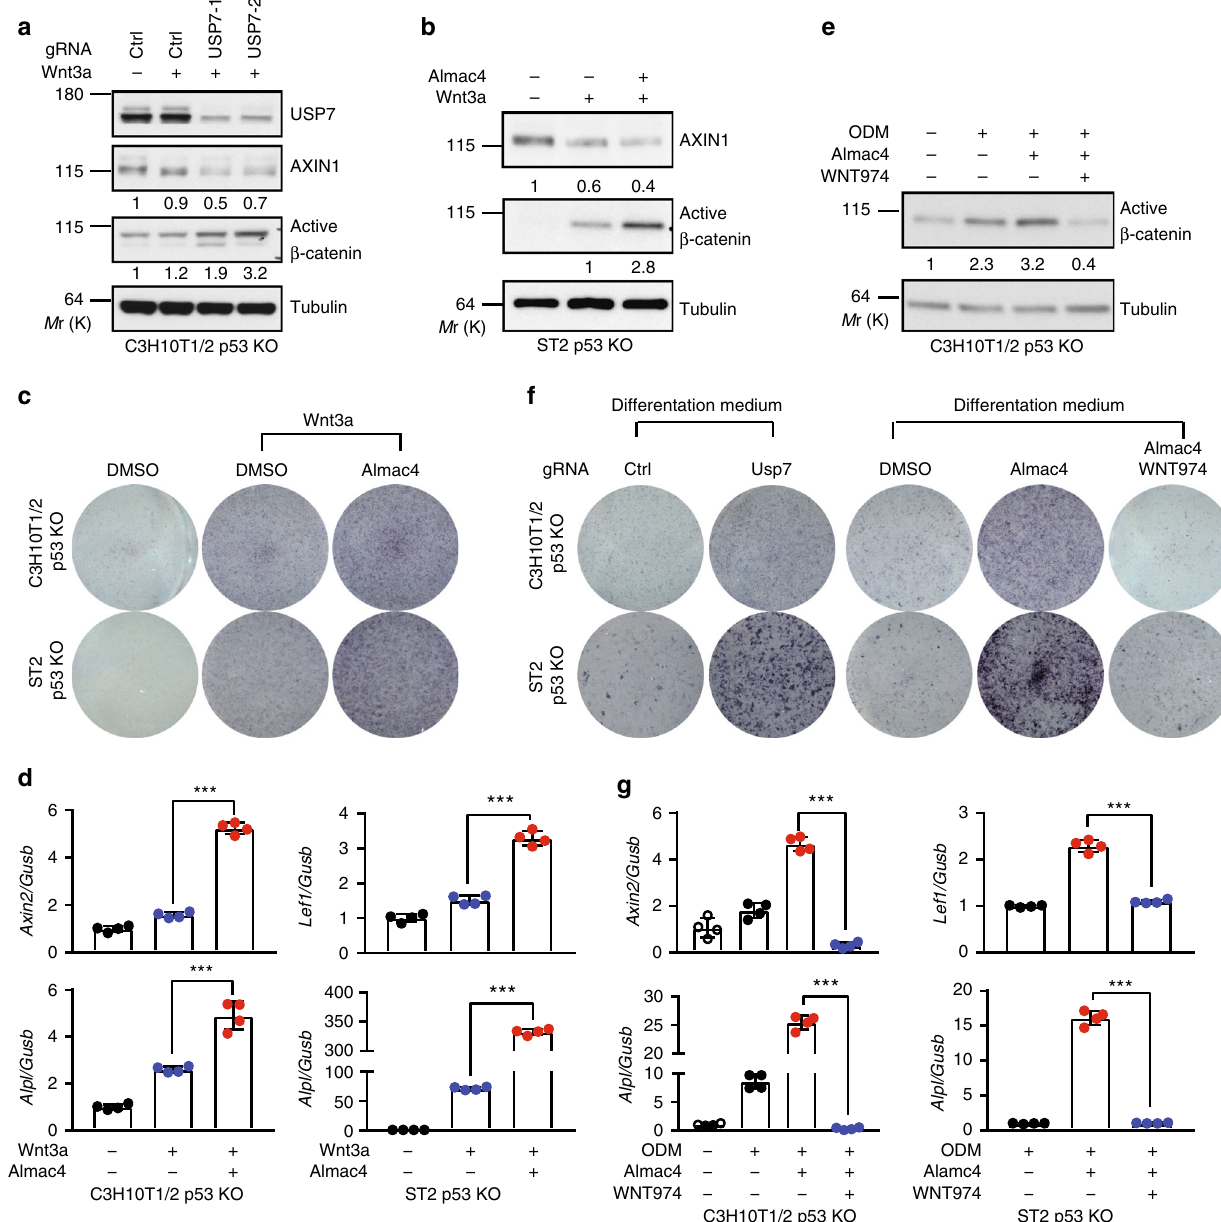
Fig. 5 USP7 inhibits Wnt-induced osteoblast differentiation. a Knockout of Usp7 enhances Wnt3a-induced active β -catenin accumulation in C3H10T1/2 p53 KO cells. Cells bearing control or Usp7 gRNA were incubated with 10% Wnt3a CM overnight. b USP7 inhibitor Almac4 enhances Wnt3a-induced active β -catenin accumulation in ST2 p53 KO cells. Cells were pretreated with DMSO or 2 µ M Almac4 for 24hrs, and then incubated with 5% Wnt3a CM overnight. ( c , d ) Almac4 promotes Wn3a-induced Alkaline phosphatase staining and β -catenin target gene and Alkaline phosphatase ( Alpl ) expression in C3H10T1/2 p53 KO and ST2 p53 KO cells. Cells were incubated with DMSO, DMSO and 2% Wnt3a CM, or 1 µ M Almac4 and 2% Wnt3a CM for seven days and subjected to alkaline phosphatase (ALP) staining ( c ) or RT-PCR assay ( d ). e Almac4 enhances osteoblast differentiation medium (ODM)-induced accumulation of active β -catenin. C3H10T1/2 p53 KO cells were cultured in regular medium or differentiation medium in the presence of DMSO, 1 µ M Almac4, or 1 µ M Almac4 and 2 µ M WNT974 for 12 days. f Genetic knockout (left panel) or pharmacological inhibition (right panel) of USP7 enhances osteoblast differentiation medium-induced alkaline phosphatase staining in C3H10T1/2 p53 KO and ST2 p53 KO cells, which is abolished by WNT974. Both control and Usp7 gRNA bearing cells were treated with differentiation medium for 12 days before the ALP staining. Conditions are the same as described in Fig. 5e. g Almac4 increases osteoblast differentiation medium-induced expression of Alkaline phosphatase ( Alpl ) and β -catenin target gene in C3H10T1/2 p53 KO and ST2 p53 KO cells, which is suppressed by WNT974. In Fig. 5d, g, error bars denote the SD between four replicates; one-way ANOVA was used to determine the statistical signi fi cance; *** p value ≤ 0.001. Source data for Fig. 5a, b, d, e, and g are provided as Source Data fi